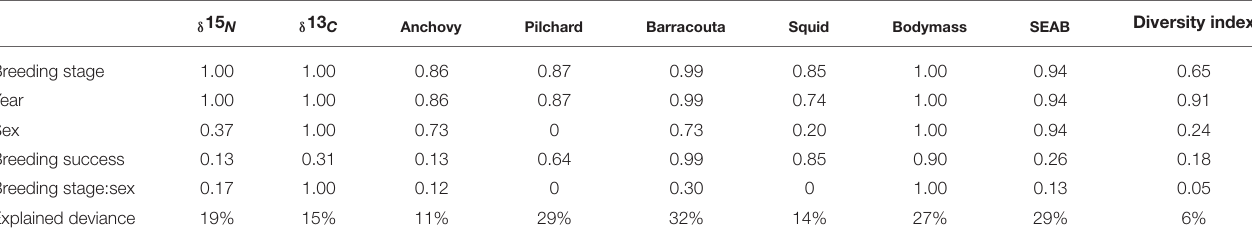
TABLE 3 | Estimates of Relative Importance of Weights (RIW) for each explanatory variable (j) calculated by the sum of Akaike weights of models where explanatory variable (j) was present.